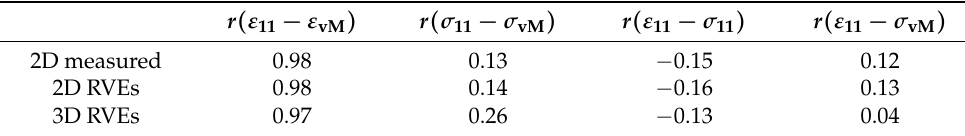
Table 3. Pearson’s coefficient for stress and strain measures.